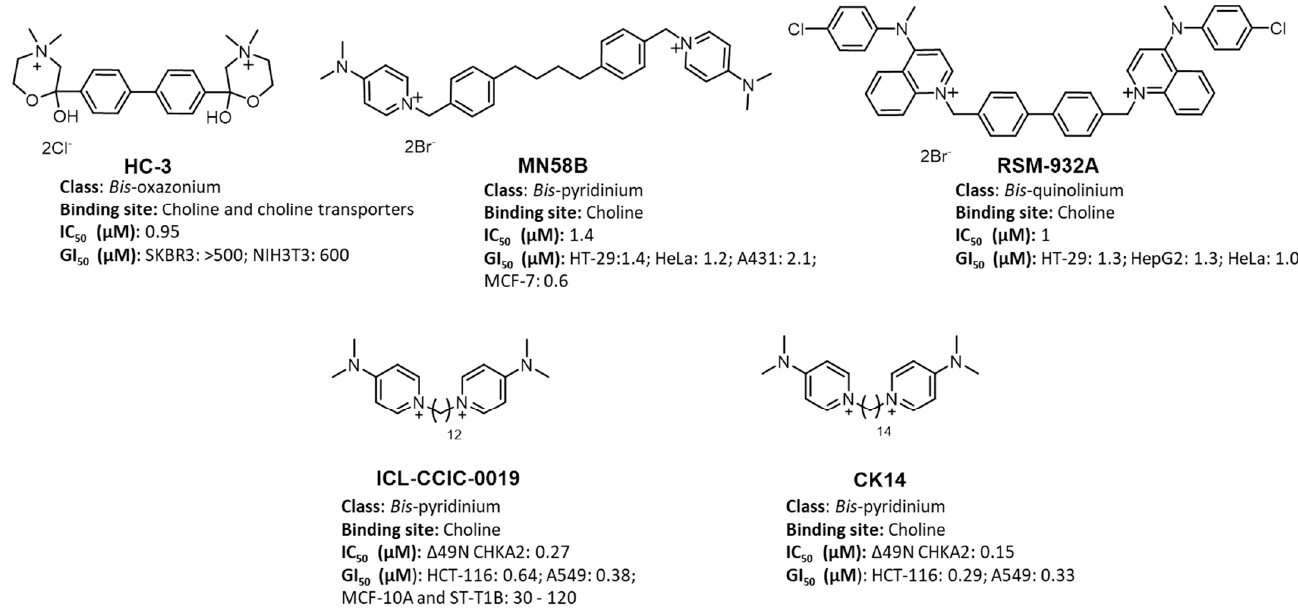
Figure 1. Chemical structures and pharmacological data of corresponding CHKA inhibitors: HC-3 [18,25], MN58B [20,21], RSM-932A [23], ICL-CCIC-0019 [26,27] and CK14 [26].